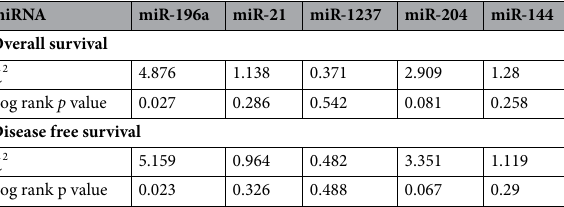
Table 4. Log rank survival statistic of the five recurrence specific miRNAs. OS overall survival, DFS disease free